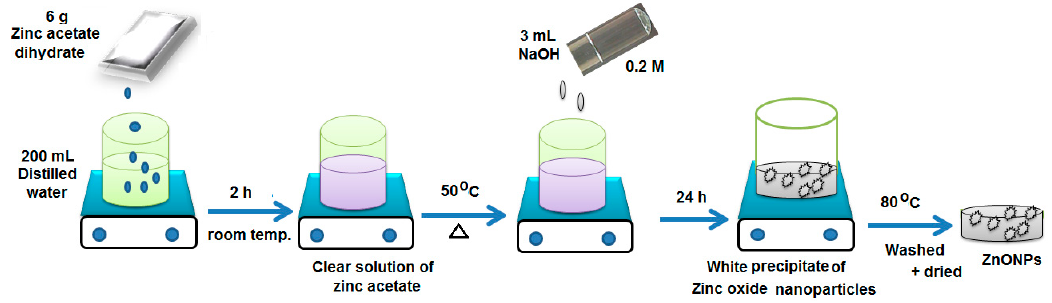
Figure 1. Sol–gel synthesis of zinc oxide nanoparticles.